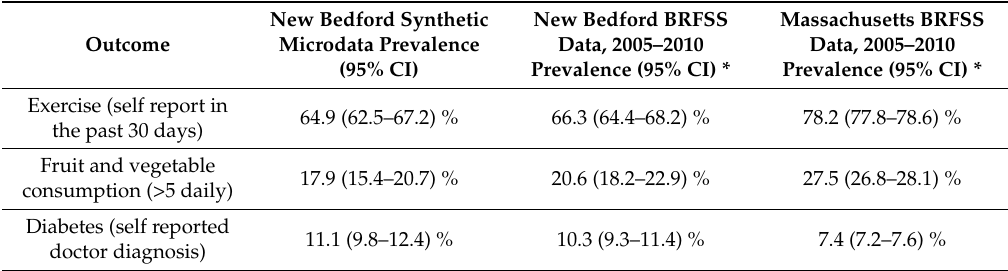
Table 2. Comparison of mean prevalence of exercising, fruit and vegetable consumption, and diabetes estimated from synthetic microdata compared to New Bedford and Massachusetts 2005–2010 BRFSS estimates for adults 21 years and